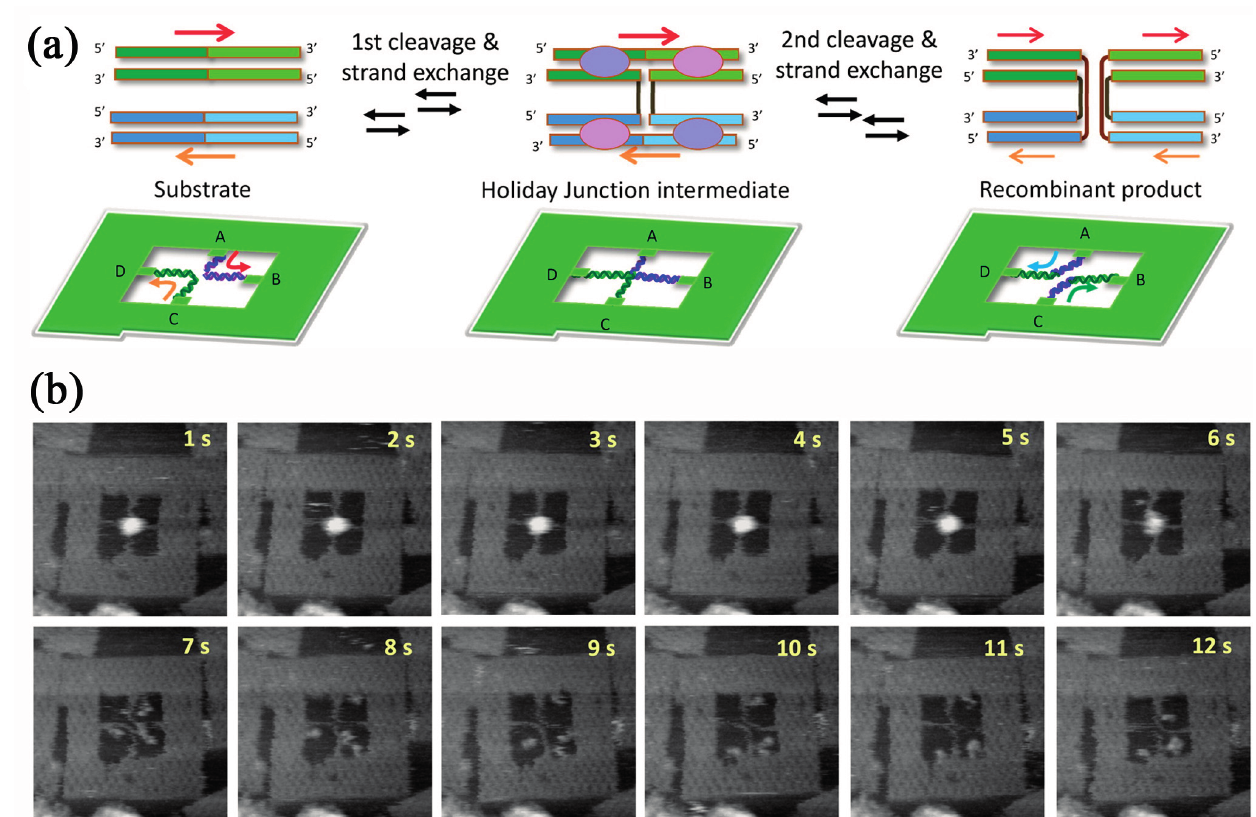
Figure 9. ( a ) Scheme of the DNA origami frame with a crossed geometry of attachment sites for the immobilization of loxP -containing DNA strands in antiparallel configuration and pathway of Cre- loxP recombination via an intermediate Holliday junction; ( b ) HSAFM images of the reaction, starting with the synaptic complex. Adapted with permission from Ref. [55]. Copyright 2013 American Chemical